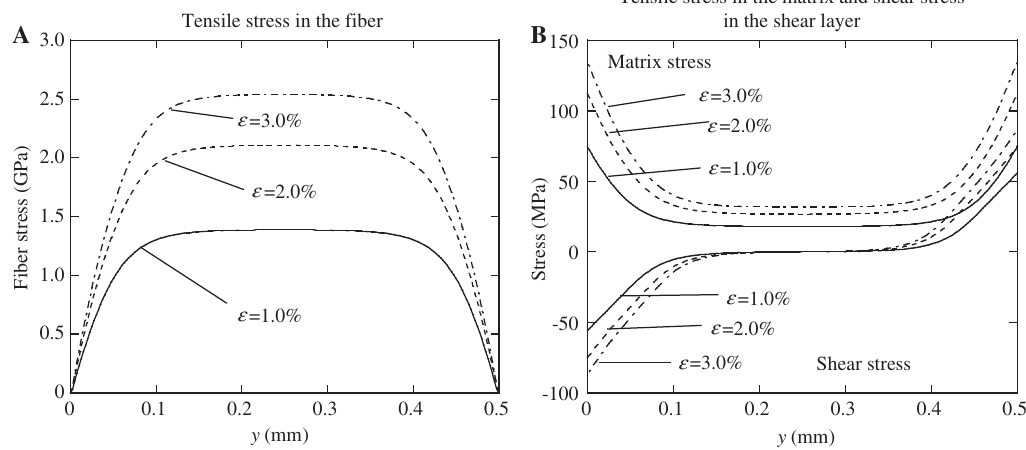
Figure 7 Stress distributions along the fi ber direction obtained by the present analysis for case (C) (a power-law effective stress-effective plastic strain relation).